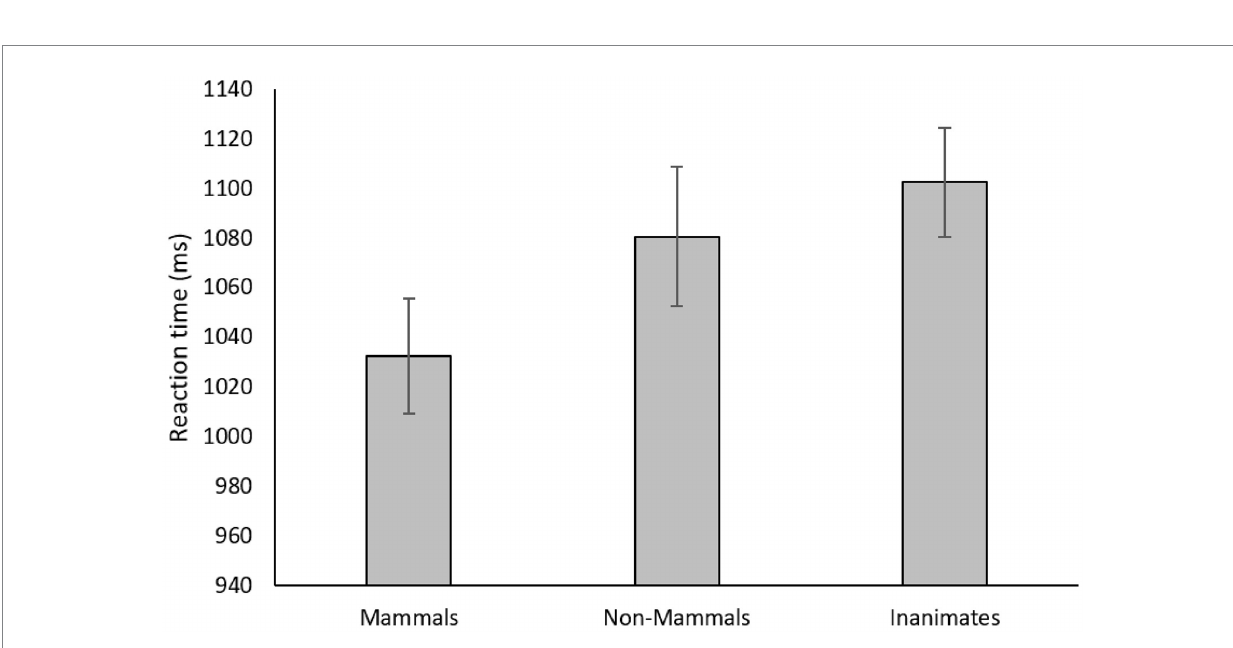
FIGURE 2 Mean reaction times as a function of entity type in Experiment 1. Error bars represent standard